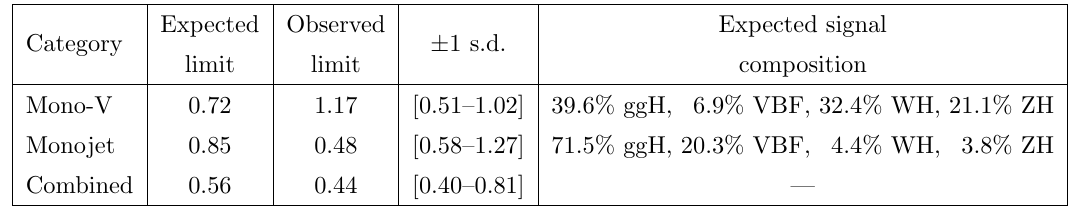
Table 5 . Expected and observed 95% CL upper limits on the invisible branching fraction of the Higgs boson. Limits are tabulated for the monojet and mono-V categories separately, and for their combination. The one standard deviation uncertainty range on the expected limits is listed. The signal composition in terms of gluon fusion, vector boson fusion, and an associated production with a W or Z boson is also provided.